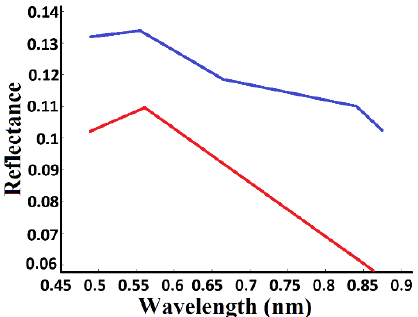
Figure 3. Selected patches in order to identify effective spectral features to detect HABs The graph of the spectral response related to these two patches is shown in Figure 4.